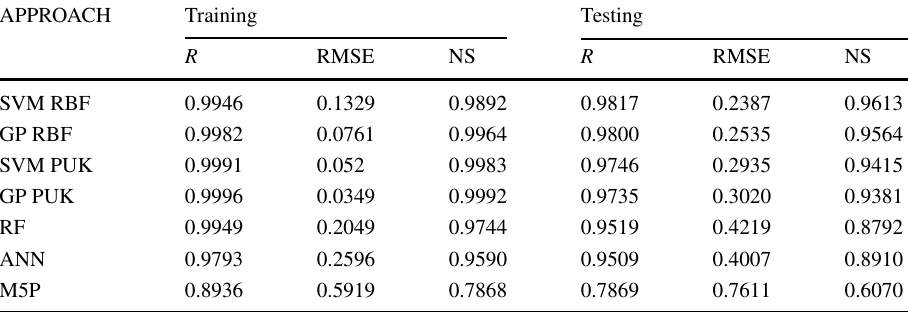
Table 5 Performance evaluation parameters of training and testing